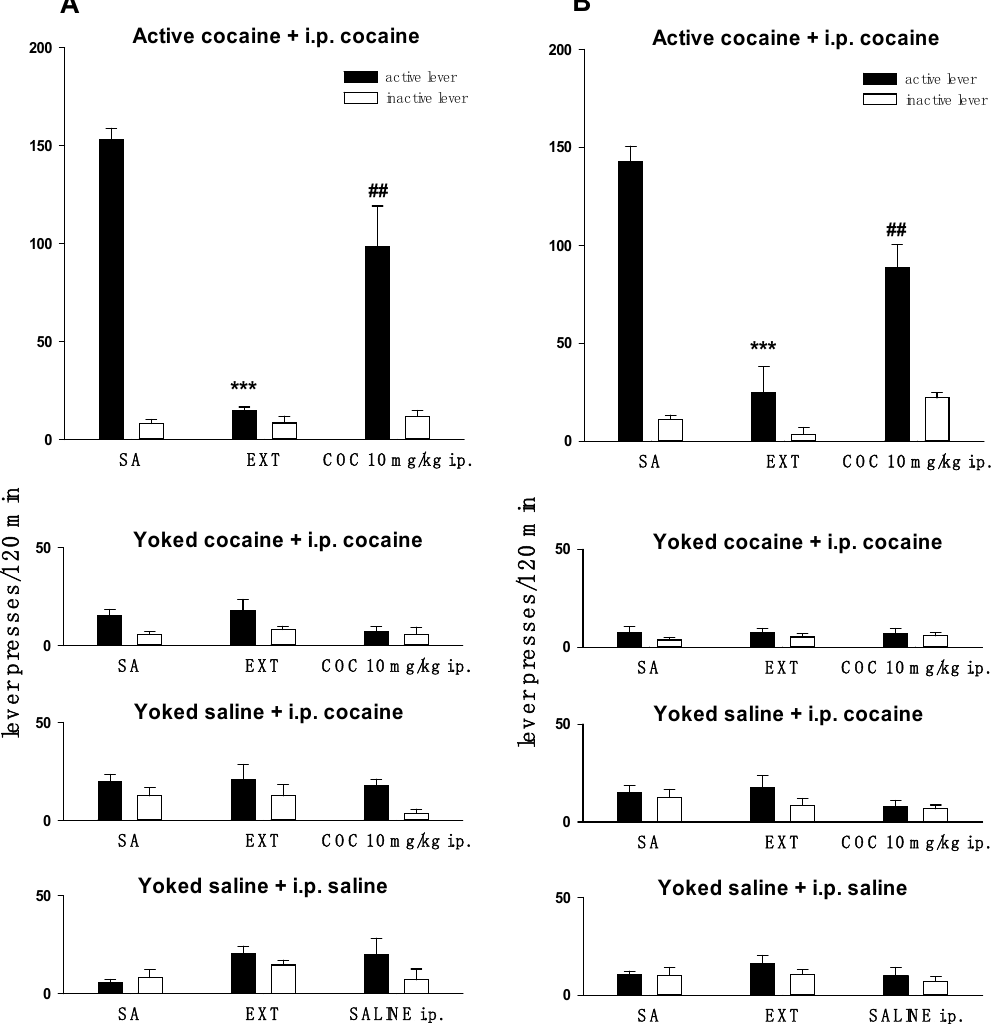
Figure 1. The number (mean ± SEM) of active (black bars) and inactive (white bars) lever presses during the last three self-administration (SA) and extinction (EXT) sessions in rats trained to self-administered cocaine (0.5 mg/kg/infusion) and forced to cocaine priming (COC 10 mg/kg i.p.) during the reinstatement test in active cocaine + i.p. cocaine, yoked cocaine + i.p. cocaine, yoked saline + i.p. cocaine and yoked saline + i.p. saline was shown. Panel A —experiment to evaluate the endocannabinoid and NAEs tissue level; panel B —experiment to evaluate the expression of cannabinoid receptors. N = 7–8 rats/group. *** p < 0.001 vs. active lever SA; ## p < 0.01 vs. active lever EXT, (Newman–Kelus